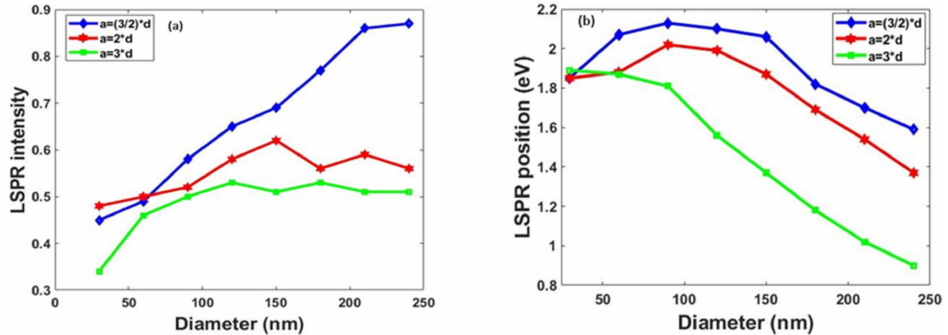
Figure 3. Size dependent LSPRs ( a ) intensity; ( b ) position for d = 30 nm–240